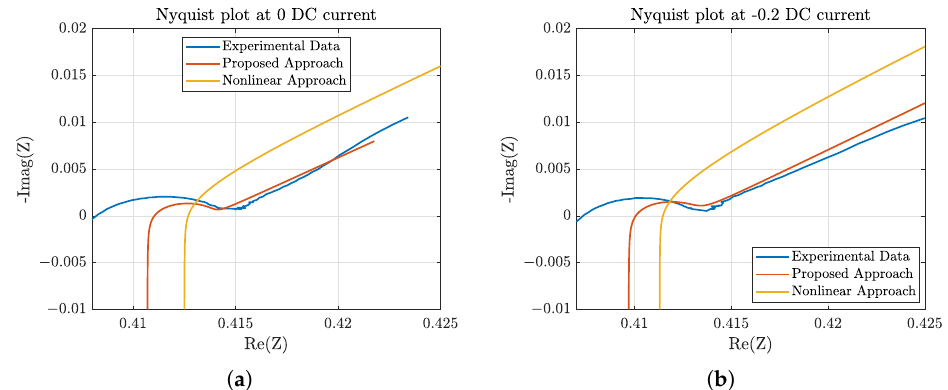
Figure 14. ( a ) Zero DC current: This figure compares the Nyquist plots of estimated parameters from the proposed and non-linear approaches to the real data ( b ) Nonzero DC current : this figure compares the Nyquist plots of estimated parameters from the proposed and non-linear approaches to the real data.